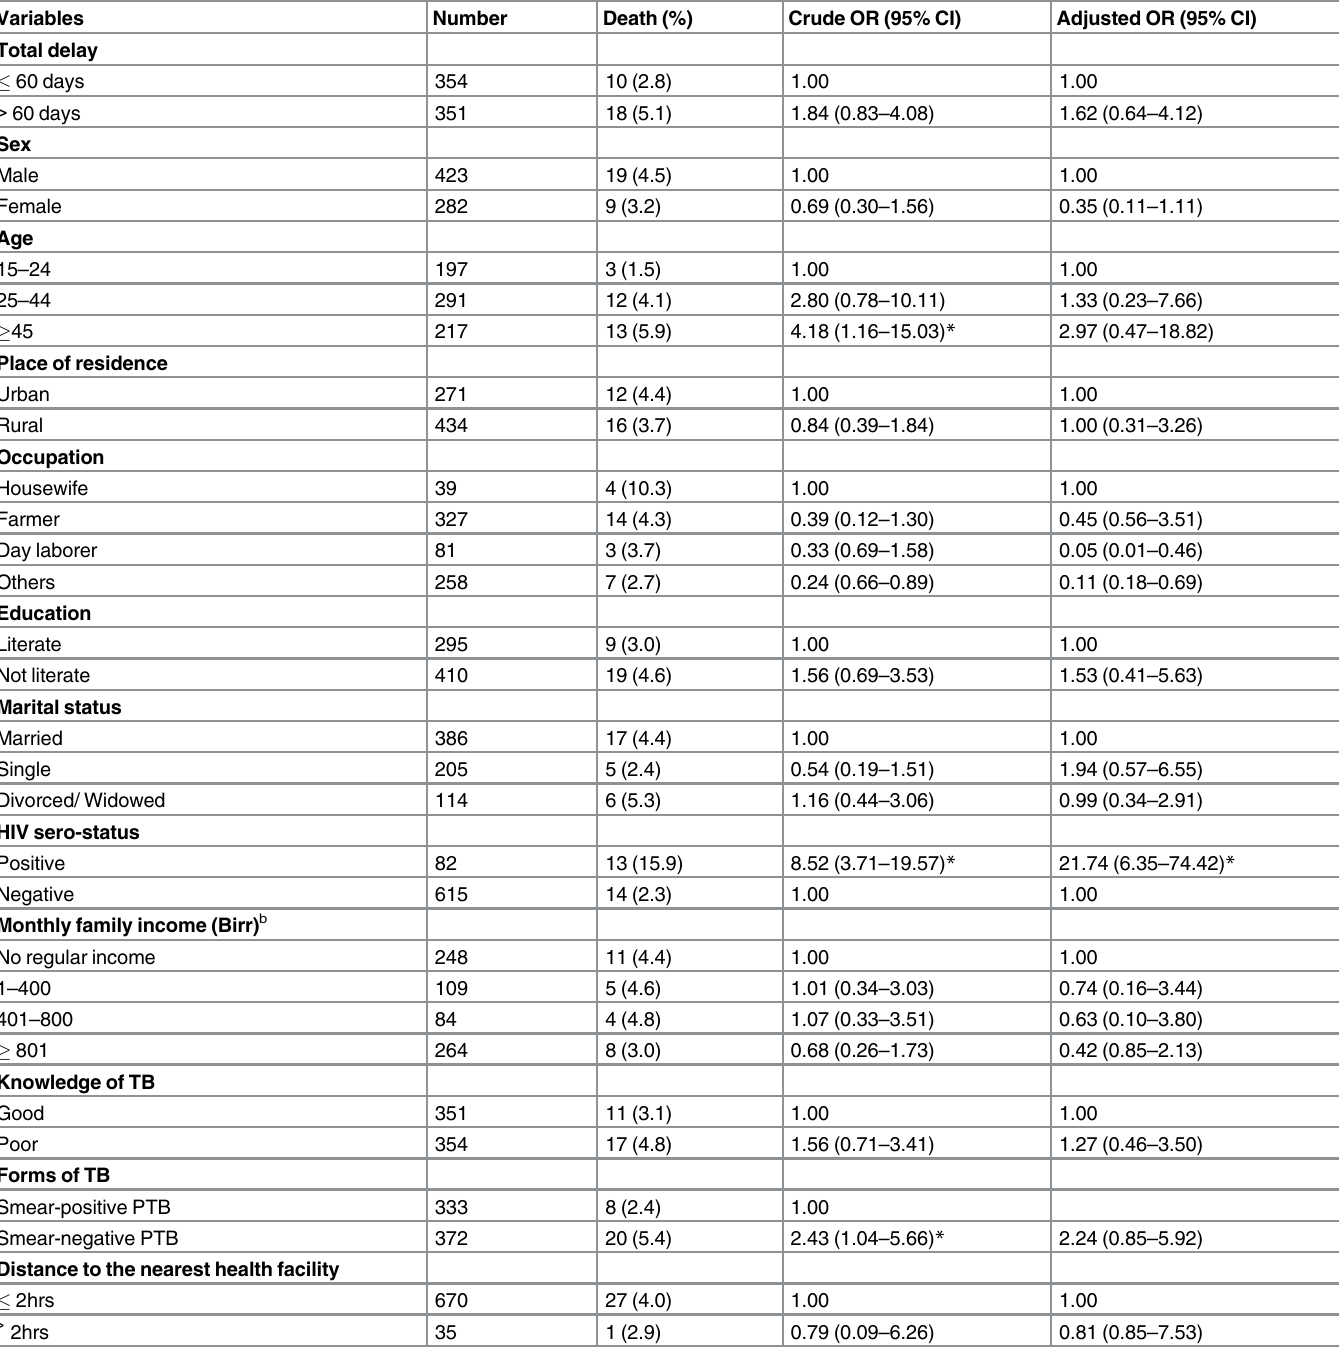
Table 7. Factors associated with death of PTB patients, October 2013 to May 2015, West Gojjam Zone,